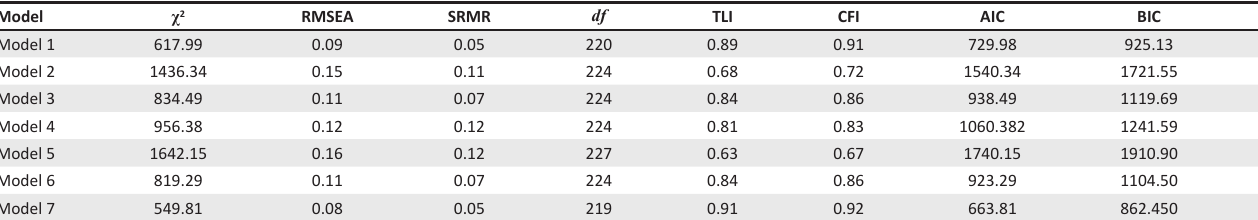
TABLE 3: Fit statistics of competing measurement models.